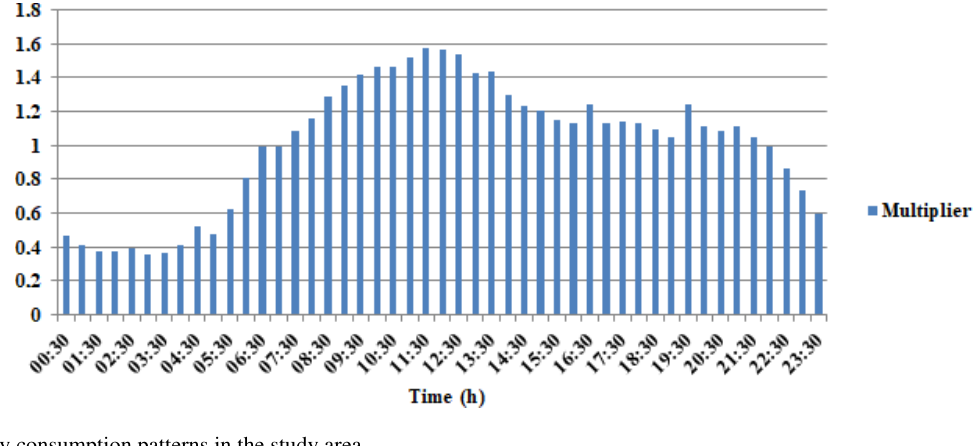
Figure 4. Daily consumption patterns in the study area.